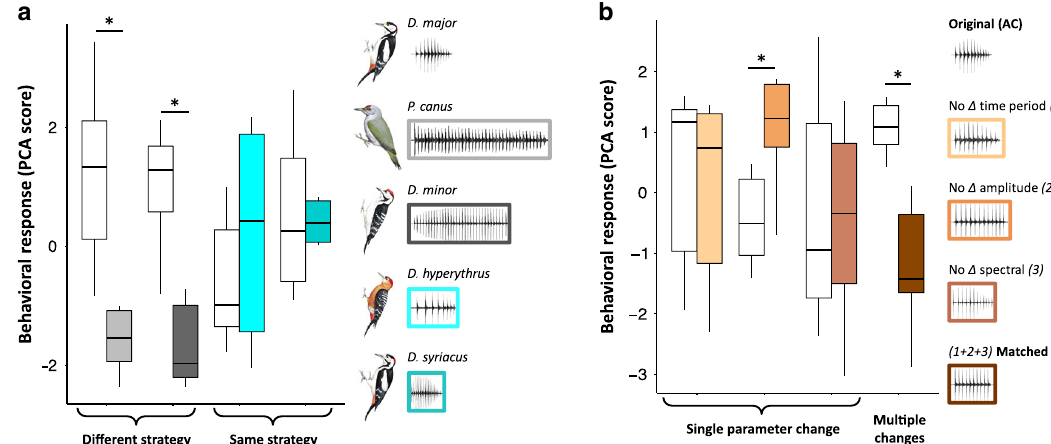
Fig. 5 Field playback experiments: behavioural response of Dendrocopos major to played back signals. a Compared with presentation of drums from their own species (white box plots), individuals ( n = 6 for each condition) did not respond to species with a different drumming type ( Picus canus ( P = 0.001; paired comparison using linear mixed model (LMM) and LSmeans contrasts) and Dryobates minor ( P = 0.009; paired comparison using LMM and LSmeans contrasts)) whereas they reacted strongly to species sharing the same type ( Dendrocopos hyperythrus and D. syriacus ; both P > 0.05; paired comparison using LMM and LSmeans contrasts). b Similar to panel a, we tested n = 6 individuals in each condition. Individuals were tolerant (no decrease in response) when only one acoustic dimension of the original signal was changed (suppression of either the inter-pulse time variation in the drumming sequence, the amplitude modulation, or the spectral modulation between successive pulses). Birds ’ reactions signi fi cantly dropped when all acoustic dimensions were affected simultaneously ( ‘ multiple changes ’ condition; P < 0.001; paired comparison using LMM and LSmeans contrasts). The higher the behavioural score, the stronger the response (i.e. birds reacted faster, approached closer and with a stronger acoustic response to the playback sequence). In both panels, box plots denote median and 25th to 75th percentiles (boxes) and min/max values (whiskers) (illustrations of woodpeckers reproduced by permission of Lynx Edicions). *Signi fi cant difference between conditions using pairwise comparisons and Tukey adjustment for multiple testing; two-tailed statistics are reported. Source data are provided as a Source data fi